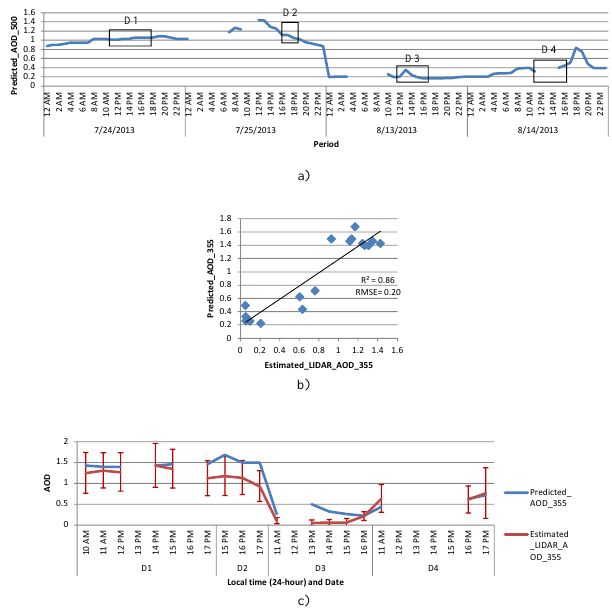
Figure 8. (a) Hourly retrieved AOD recorded on (a) 24–25 July and 13–14 August 2013 (the gaps are due to fog, rain, or when API value is predominantly caused by O 3 but not PM 10 ) . (b) A scatter plot for AOD_355 predicted from our model versus the AOD cal- culated from Raymetrics LIDAR system. (c) Predicted AOD from our model and estimated AOD from LIDAR plotted versus local time and date (the gaps indicate no data available at the particular time due to LIDAR system was switched off or cloud contamina- tion above the LIDAR system). Error bars for estimated AOD from LIDAR are